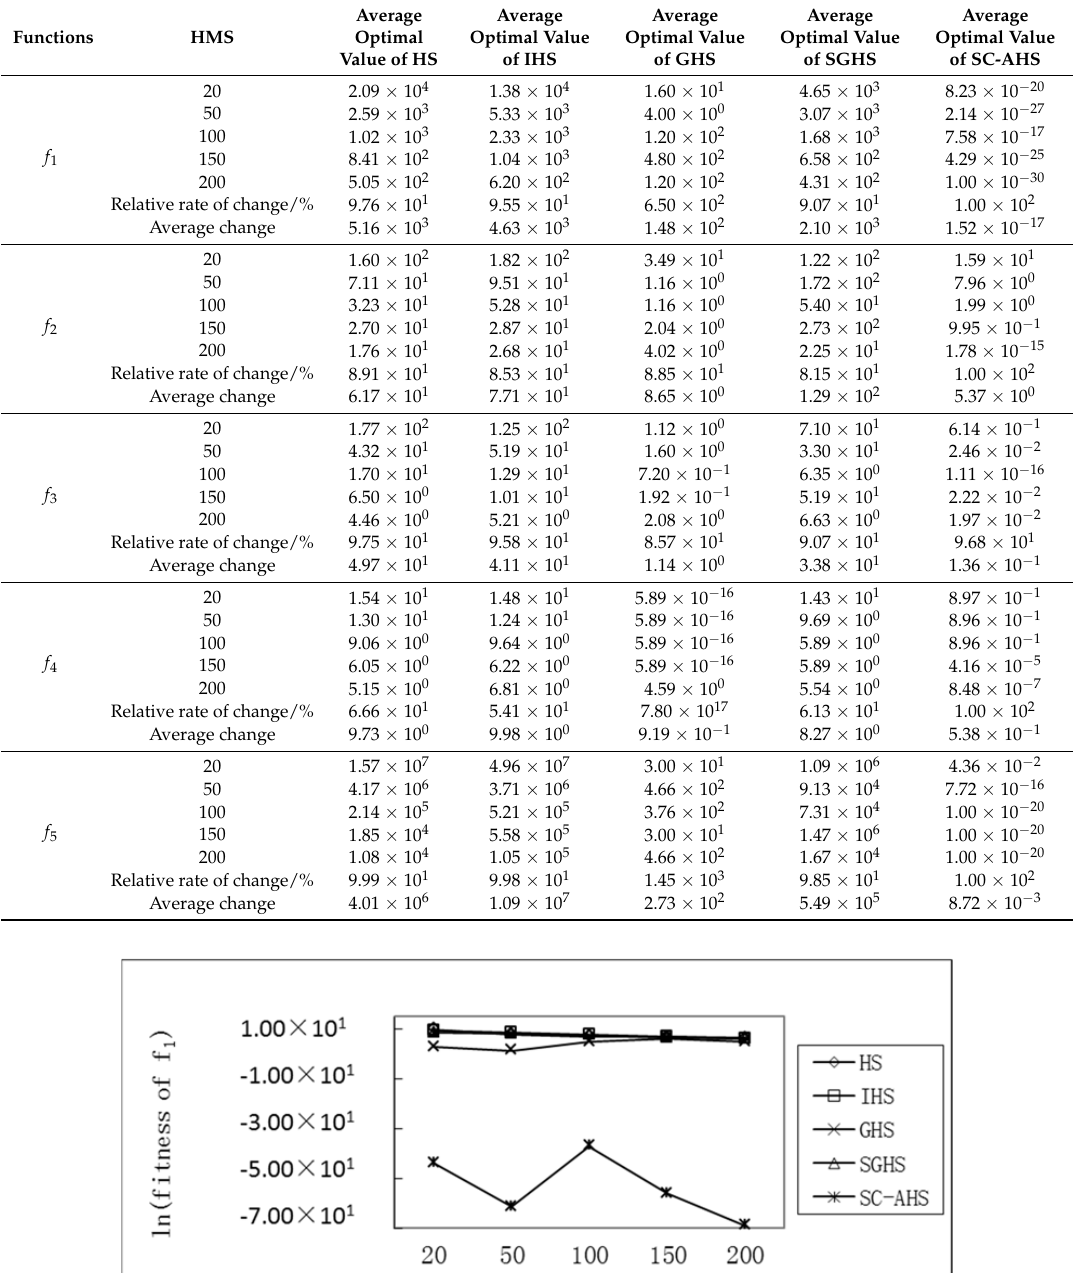
algorithm is shown in Table 4. The comparison of the average optimum value of each function changed with the size of the harmony memory as showed in Figures 7–11. Table 4. Comparison of the optimal performance with different harmony memory sizes of five functions.